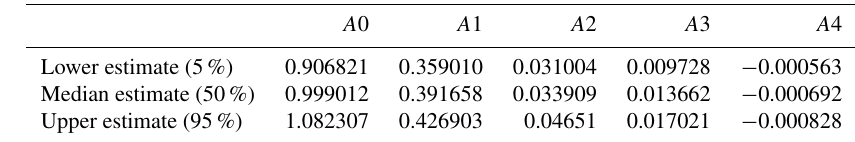
Table 3. Polynomial coefficients (fourth order) that describe the lower, median, and upper precipitation frequency curves for Altus. Table reproduced from Table 5.7 in Reclamation (2012).